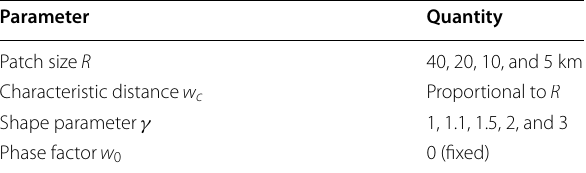
Table 2 Variables for a single patch case